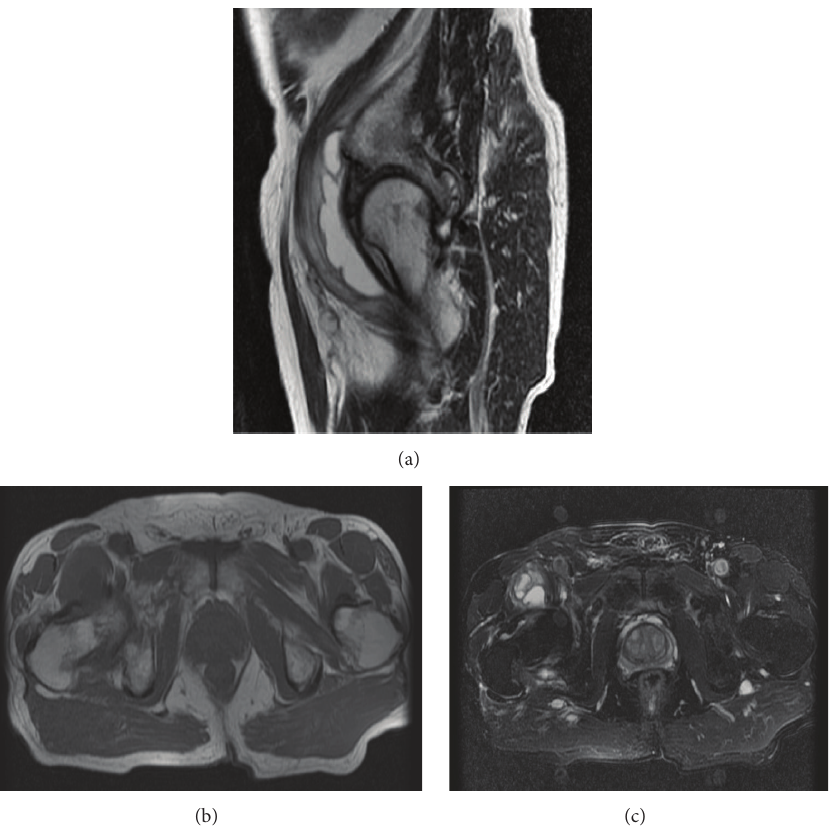
Figure 2: Magnetic resonance imaging (MRI). An elongated neoformation with predominantly fluid content is shown, multiloculated and localized in the anterior-lower aspect of the right hip joint. (a) Sagittal T2-weighted scan. (b) Axial T1-weighted magnetic resonance (MR) image. (c) Axial short tau inversion recovery (STIR) MR image.